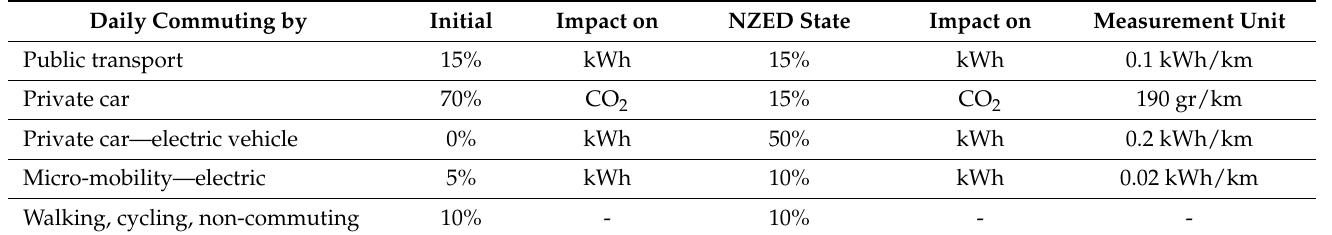
Table 5. Means of transportation to